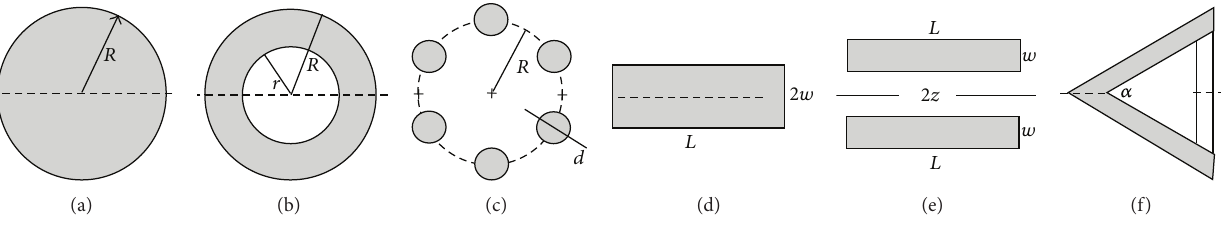
Figure 15: Simplest schema of space distribution of input energy.